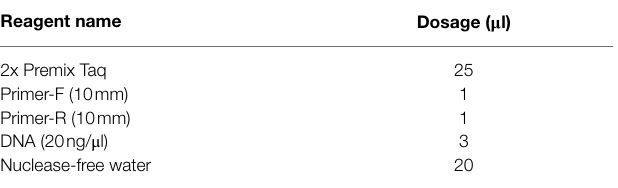
TABLE 1 | PCR reaction